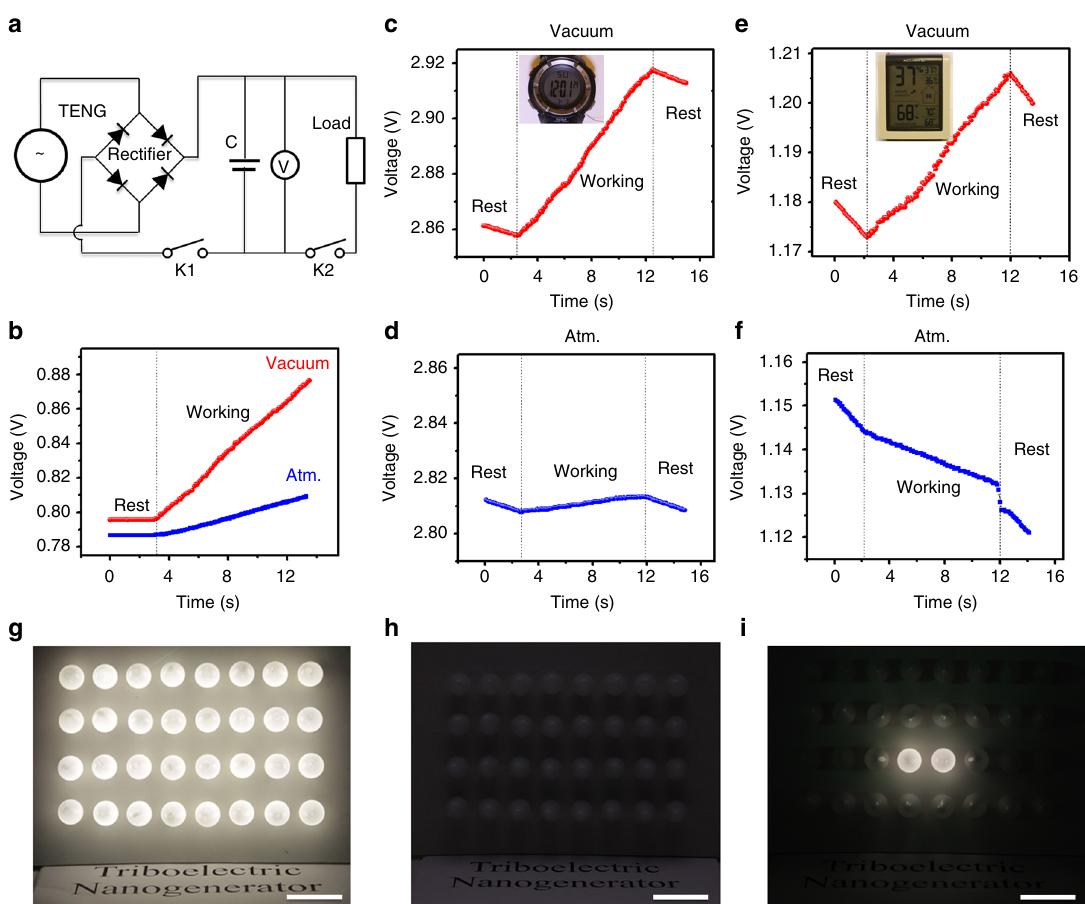
Fig. 4 Application of the TENG to drive electronics devices. a Circuit diagram of the self-powered system consisting of the TENG and a supercapacitor. b Charging curves of the supercapacitor by pressing the TENG inatmosphere and high vacuum ( P ~ 10 − 6 torr). c , d Charging curves of the supercapacitor in high vacuum c and in atmosphere d when an electronic watch is driven by the TENG simultaneously. e Charging curve of the supercapacitor when a temperature – humidity meter is driven by the TENG in high vacuum simultaneously. f Discharging curve of the supercapacitor when the TENG in atmosphere is unable to drive the temperature-humidity meter alone. g Thirty-two LED light bulbs (each with rated power of 0.75 W) are lit in complete darkness by the TENG in high vacuum, h Thirty-two LED light bulbs cannot be lit by the TENG in atmosphere, i two LED light bulbs are lit in complete darkness by the TENG in high vacuum; Scale bar, 4